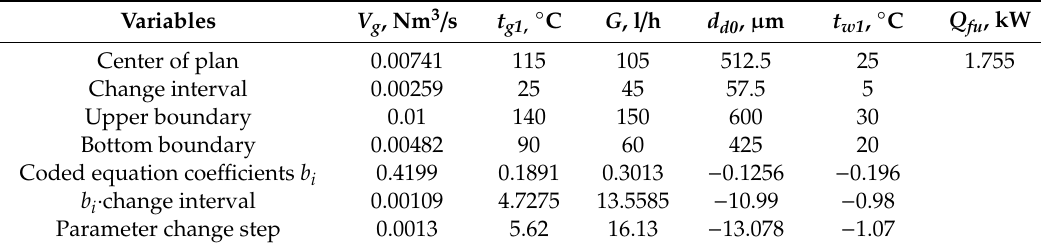
Table 2. Factor change steps in optimization.